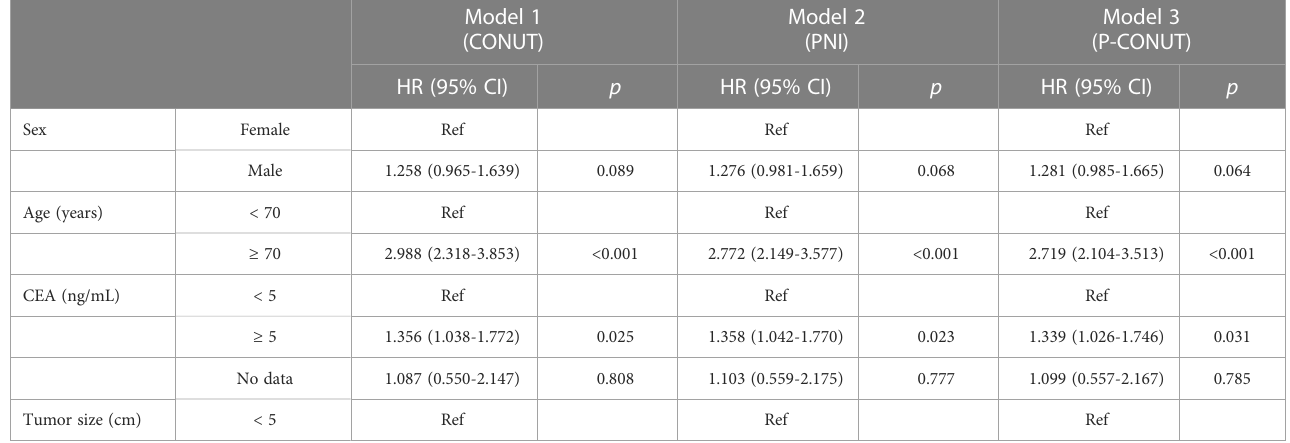
TABLE 3 Multivariable analysis associated with the overall survival